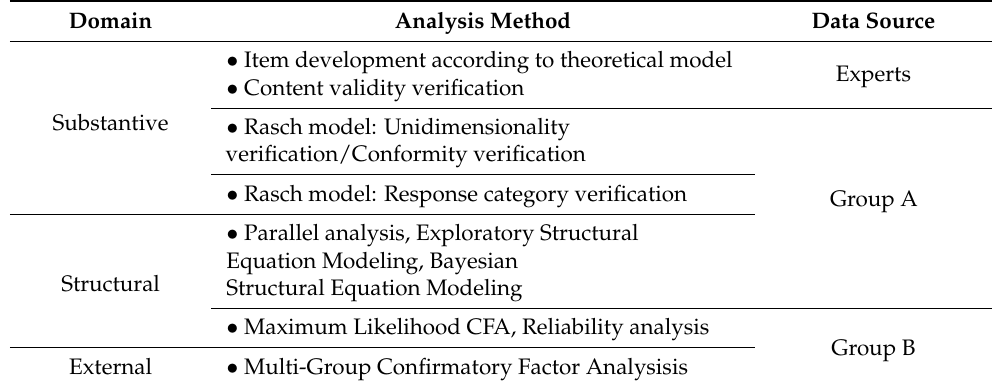
Table 3. Construct Validity